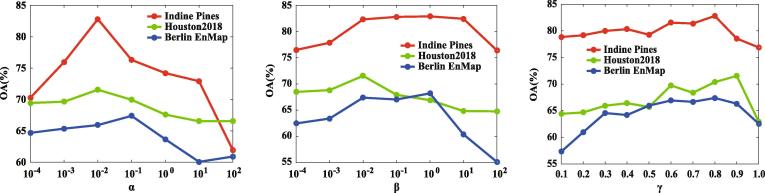
Sensitivity analysis on the regularization parameters (e.g., α,β, and γ) of the IMR in Eq. (5).